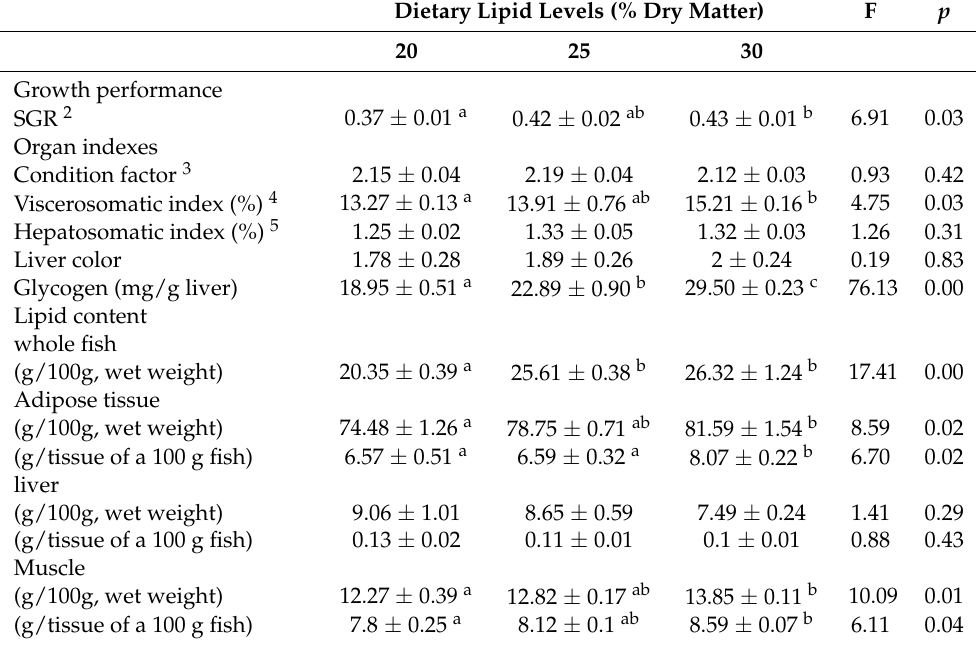
Table 3. Growth performance, organ indexes, and lipid content of whole fish, abdominal adipose tissue, liver, and muscle of triploid rainbow trout fed the experimental diets for 77 days 1